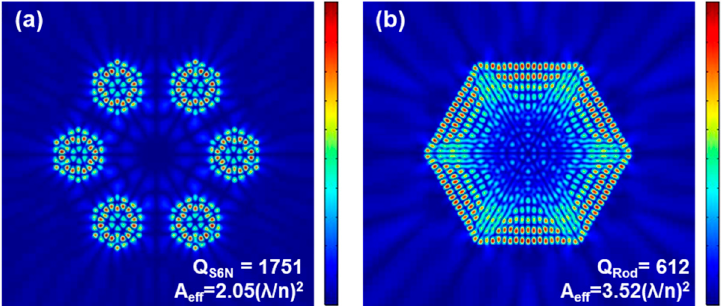
Figure 6. The intensity profiles of ( a ) a PM consisting of a 6-nanorod whose rod-to-rod spacing was optimized for a maximum Q-factor; ( b ) a 2.8 µ m wide microrod whose device footprint and resonant wavelength were both close to those of ( a ).